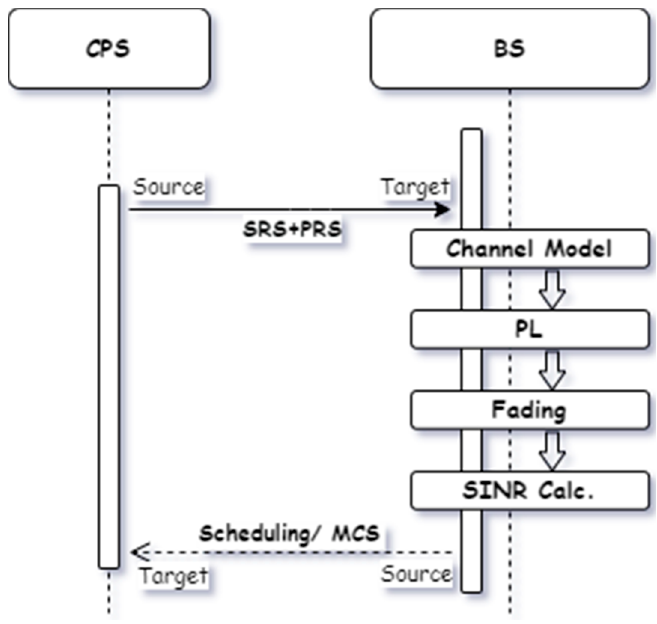
Figure 6. Data Figure 6. Data acquisition.